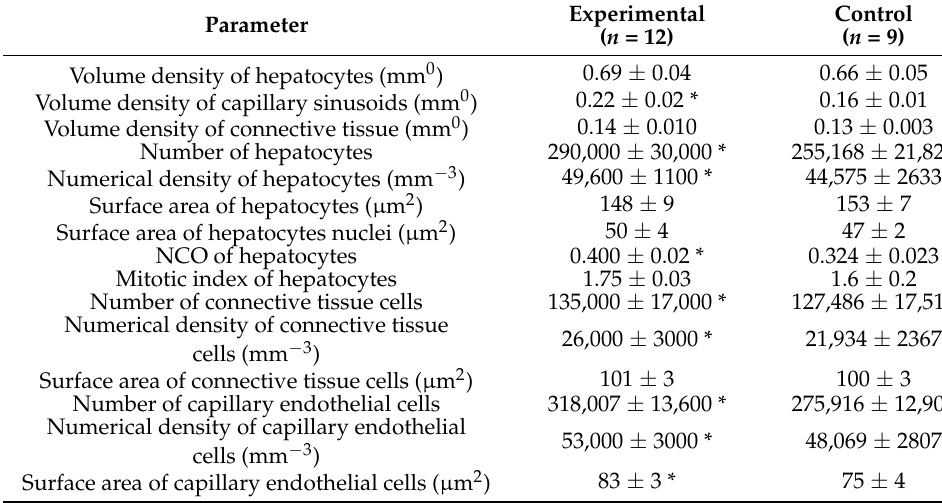
Table 2. Stereological parameters of the liver of the control and treated groups of rats; values are shown as mean ± SD; Mann–Whitney U-test, * p <